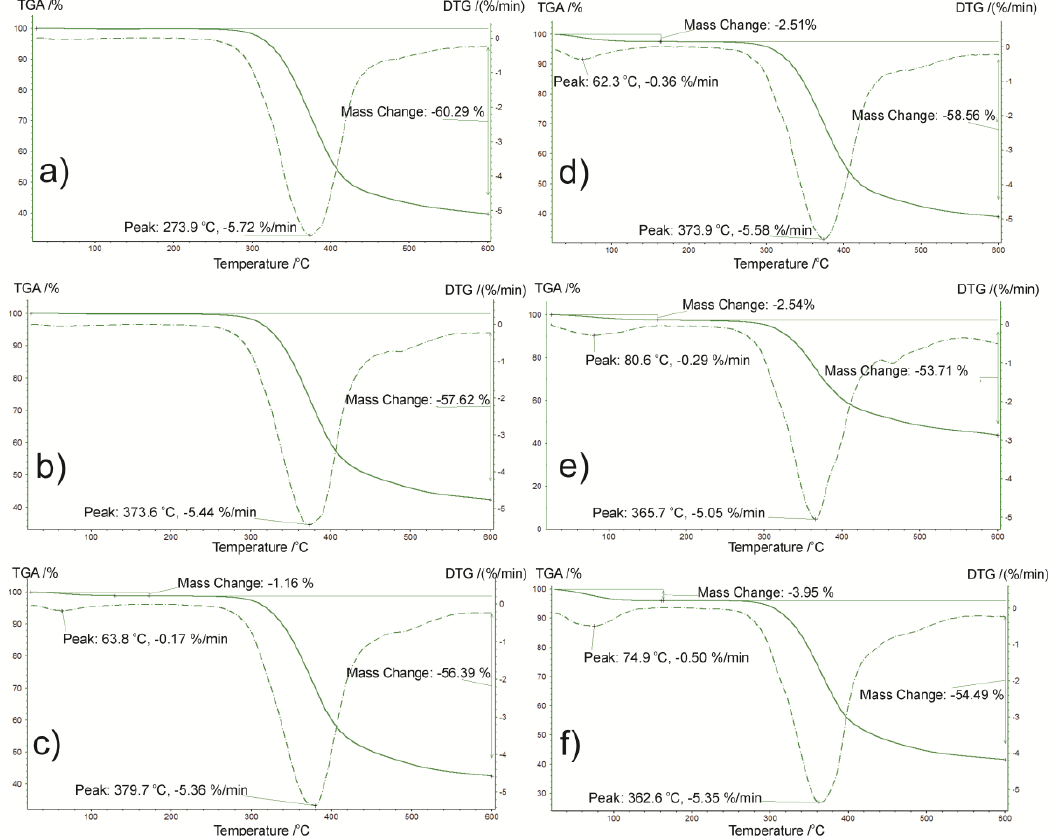
Table 4. The thermal decomposition parameters of amorphous imatinib mesylate (IM).